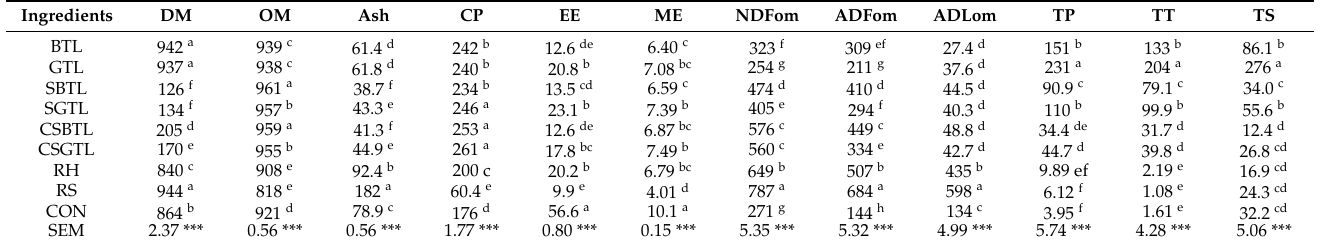
Table 2. Mean ( n = 3) chemical composition (g/kg DM except DM = g DM/kg and ME = MJ/kg DM) of ingredients of the experimental diets with SEM and significance.